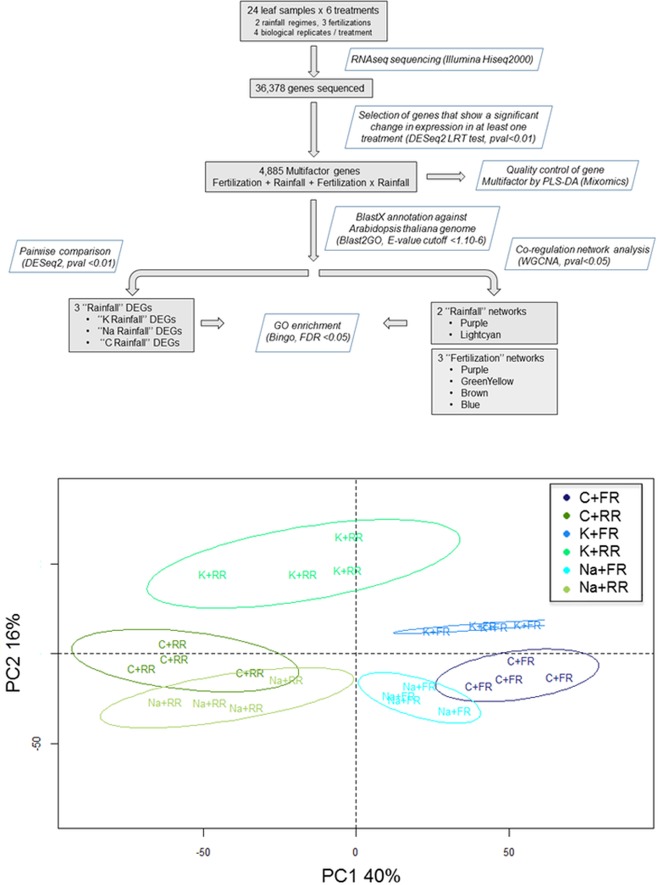
Selection of significant genes.(A) Flowchart showing the data selection process. (B) PLS-DA of 4,885 Multifactor DEGs on the first two components.